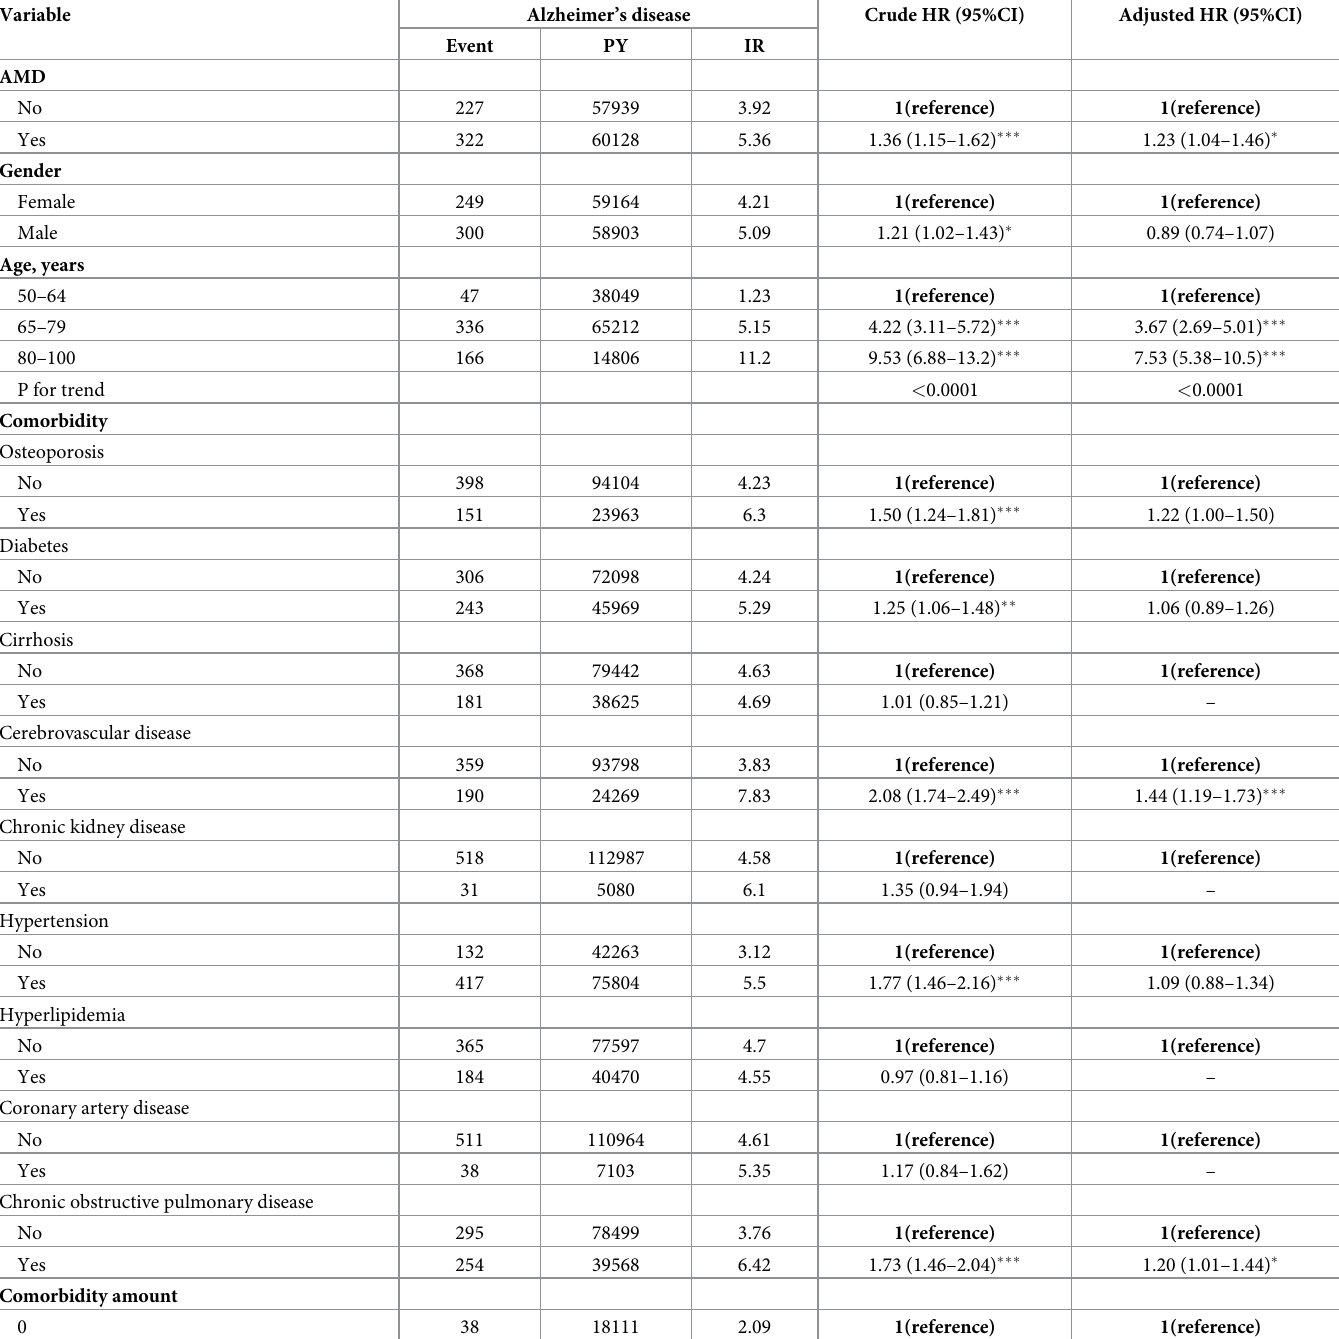
Table 2. Cox proportional HRs for risk of Alzheimer’s disease in patients with and without AMD, in different gender, age groups, and in patients with preexisting